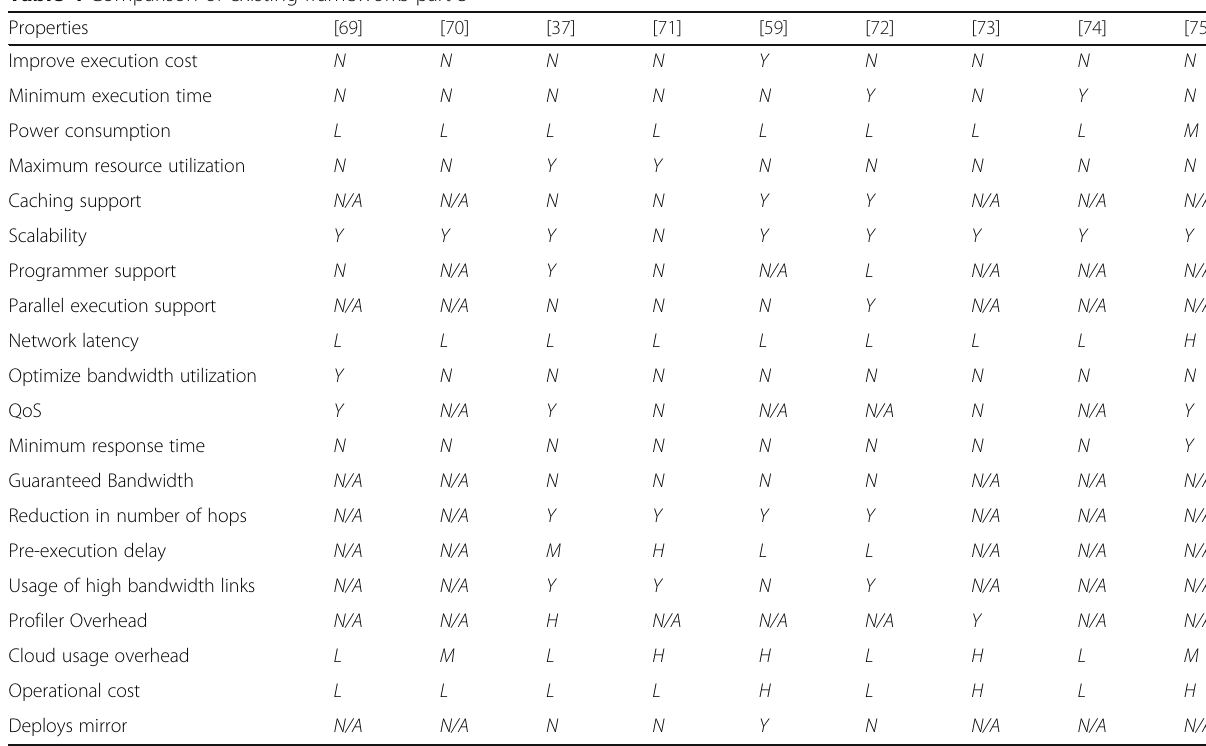
Table 4 Comparison of existing frameworks part-3